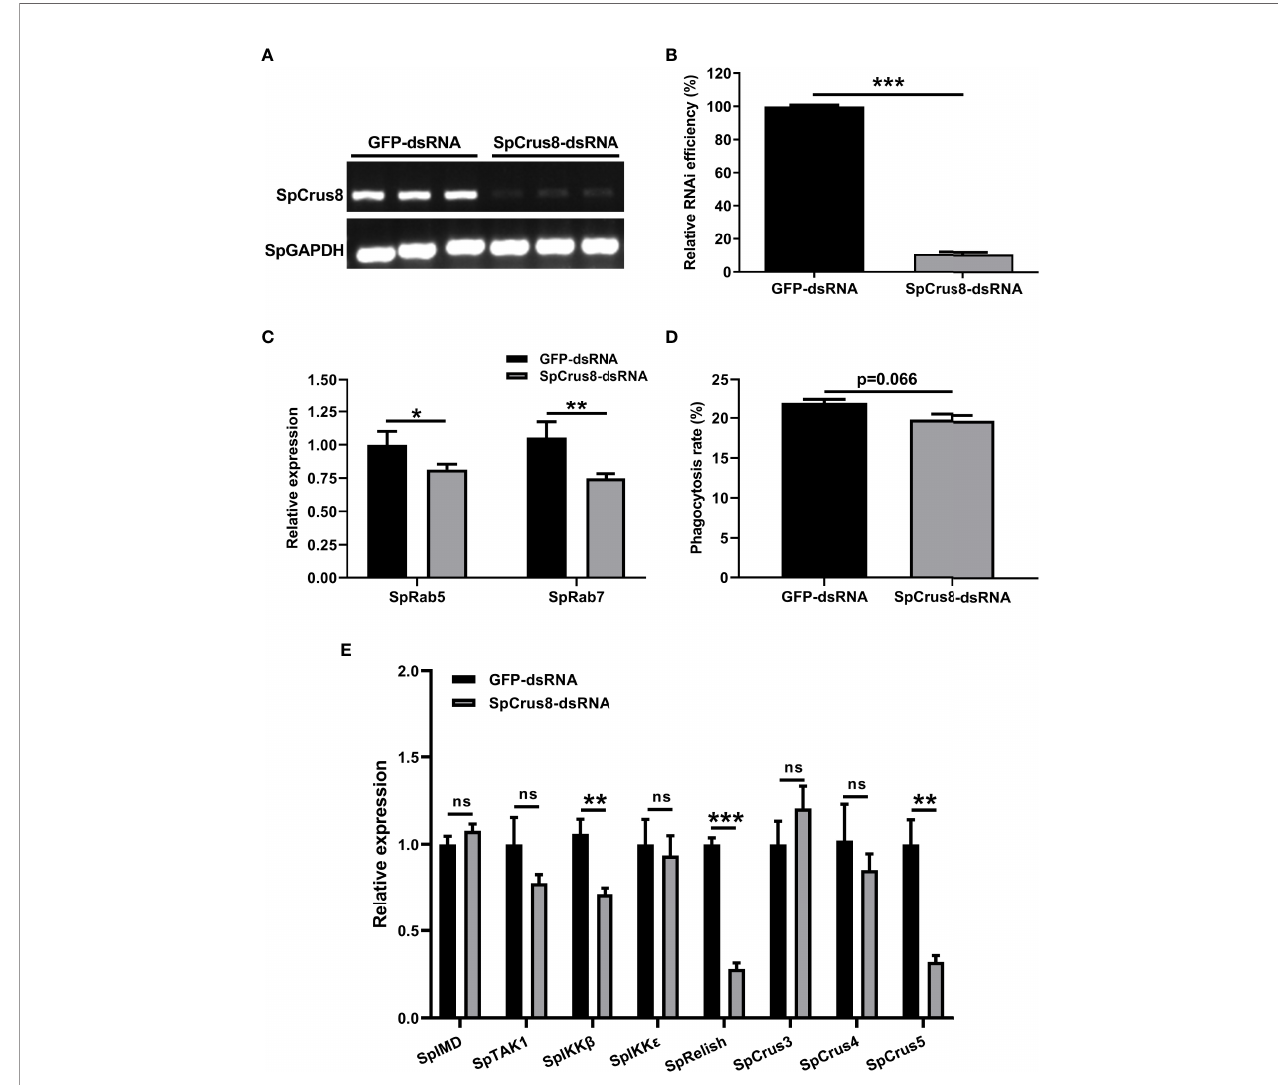
FIGURE 6 | Effect of SpCrus8 gene knockdown on phagocytosis rate and immune-related gene expression in hemocytes. The RNA interference ef fi ciency of SpCrus8 was detected by RT-PCR (A) and analyzed by ImageJ (B) , and SpGAPDH was used as the internal reference. (C) The expression of phagocytosis-related genes (SpRab5 and SpRab7) in hemocytes were examined by qPCR (n=3). (D) The phagocytosis rate of fl uorescent microspheres by hemocytes after SpCrus8- dsRNA or GFP-dsRNA treatment was determined by fl ow cytometry. (E) The expression of immune-related genes (SpIMD, SpTAK1, SpIKK b , SpIKK ϵ , SpRelish, SpCrus3,SpCrus4 and SpCrus5) in hemocytes were examined (n=3) after being treated with SpCrus8-dsRNA. Signi fi cant difference between SpCrus8-dsRNA treatment group and GFP-dsRNA group was indicated with asterisks, *p < 0.05, **p < 0.01, and ***p < 0.001, and ns represented no signi fi cant